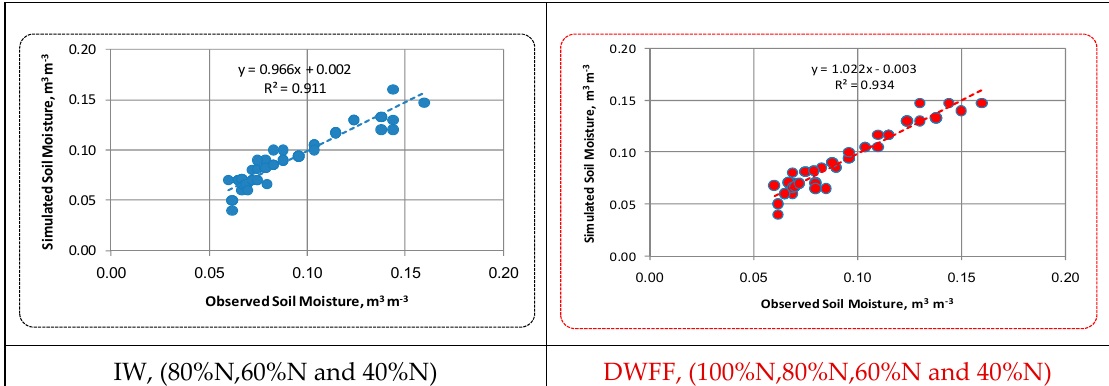
Figure 4. Soil moisture calibration for fresh irrigation water and 100% N during the 2017/2018 season.